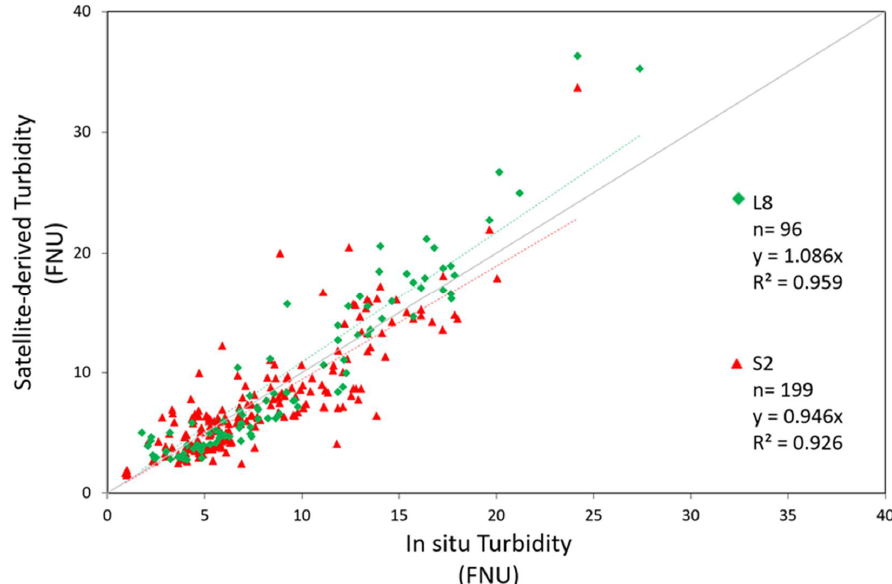
Figure 3. Scatter plot of the L8- and S2-derived turbidity vs. in situ turbidity measurements for 295 match-ups, sampled at the time of the satellite overpasses in 2017–2020. Turbidity values were retrieved according to [47]. Dashed green and red lines are the best-fit regression for L8 and S2, respectively. Grey solid line is the 1:1 line.